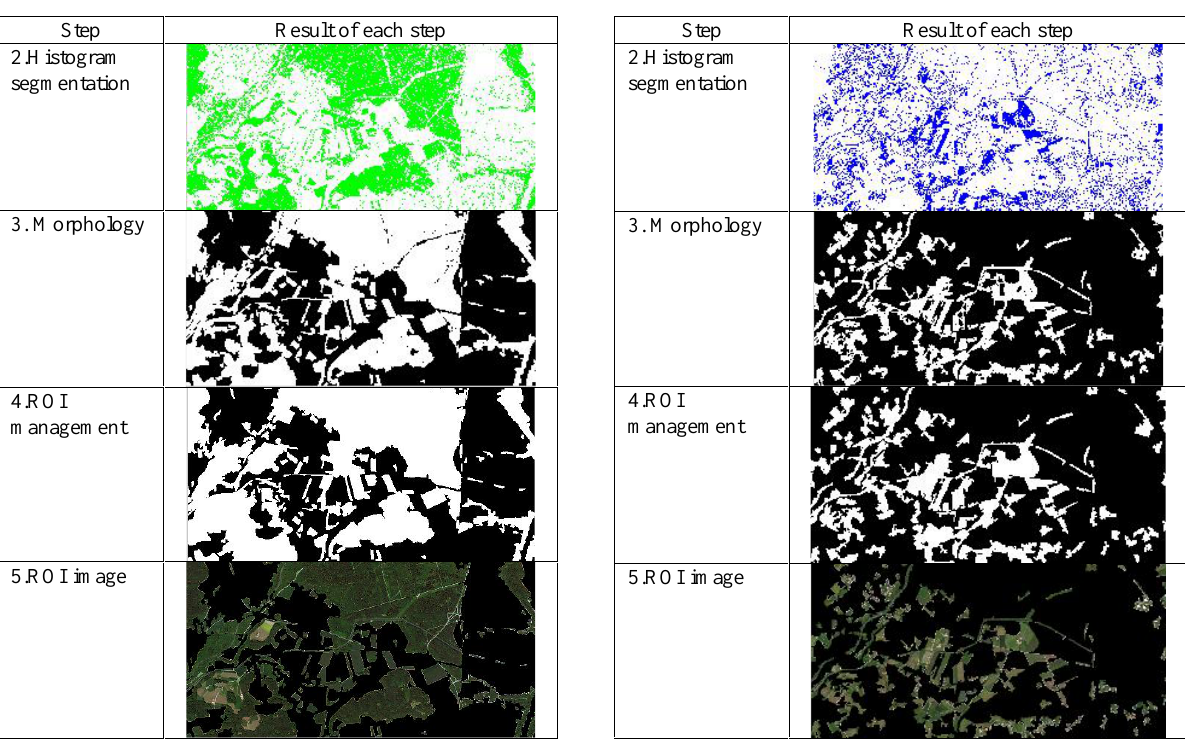
Table 2. The result of the proposed system of each process to